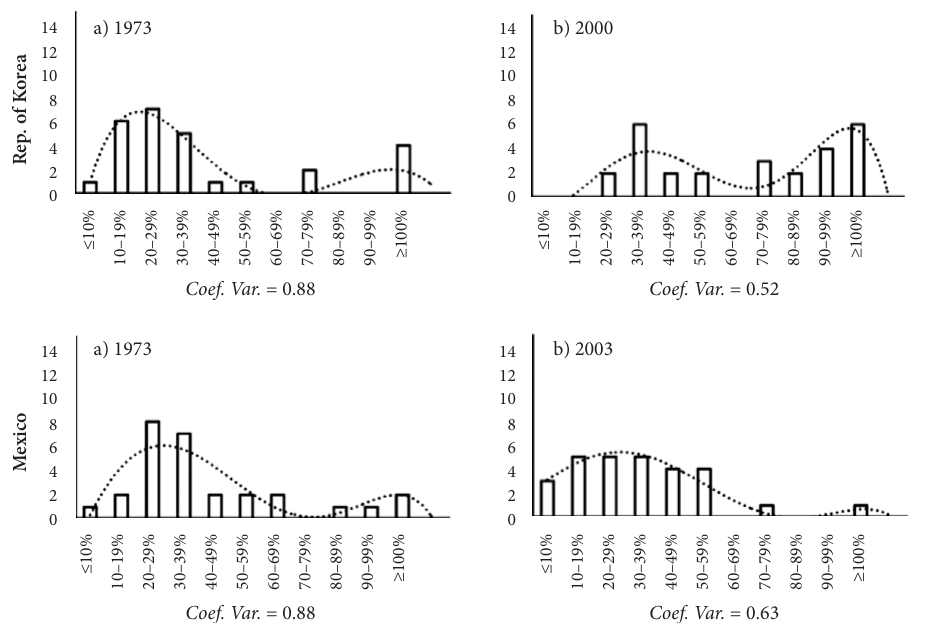
Fig. 2. Distribution of sectors by labor productivity in the Rep. of Korea and Mexico Source : (Lavopa, Szirmai 2011) reproduced with permission from authors.